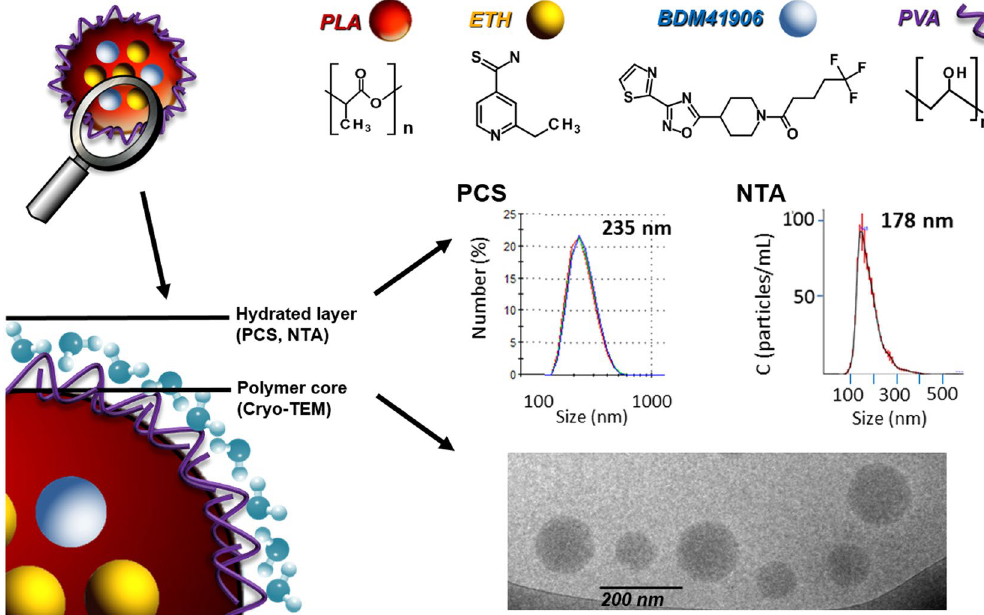
Figure 1. Chemical structure of PLA NPs components (nanoemulsion technique) and characterization of NPs mean diameter using three independent methods, PCS (number average data), NTA and Cryo-TEM. Typical example of NPs encapsulating [ETH:Booster]. Schematical representation of PLA NPs structure and components. Cryo-TEM allows determining the dry diameter (polymer core), whereas PCS and NTA allow measuring the hydrodynamic diameter (Polymer core + hydrated layer).